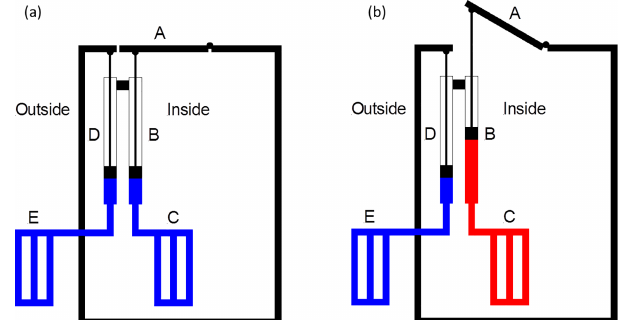
Figure 1. Schematic diagrams illustrating how the vent control sys- tem responds to air temperature differentials between the inside and outside of the chamber. Movable vent (A) is connected to a hy- draulic cylinder (B) which is connected to a liquid-filled heat ex- changer (C) located inside the chamber. Cylinder B is connected to another hydraulic cylinder (D). A pivoting bar (not shown) ex- tends from the connecting link to the chamber frame to stabilize the pistons. A counterweight connected to the connecting link ap- plies upward force on both cylinders to counteract their weight and maintain positive internal pressures on both cylinders. The piston rod on cylinder D is connected to a fixed point on the chamber and hydraulically connected to another liquid-filled heat exchanger lo- cated outside the chamber (E). The pistons in the cylinders respond to expansion and contraction of the liquid volumes in the heat ex- changers due to temperature. The liquid volumes and piston posi- tions are initially adjusted so the vent is closed when the temper- atures inside and outside of the chamber are equal (a) . When the chamber interior is warmer than the ambient environment outside the chamber (b) , the liquid in the heat exchanger inside the cham- ber (C) will expand more than the fluid in the heat exchanger outside the chamber (E), causing the piston in cylinder B to move more than the piston in cylinder D. This differential in piston positions causes the vent (A) to